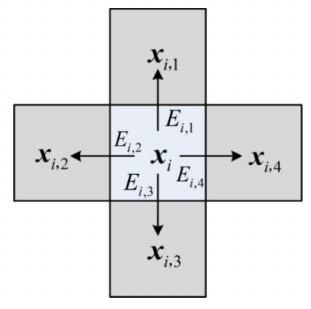
Figure 3. Illustration of computing the block-based gradient of x i